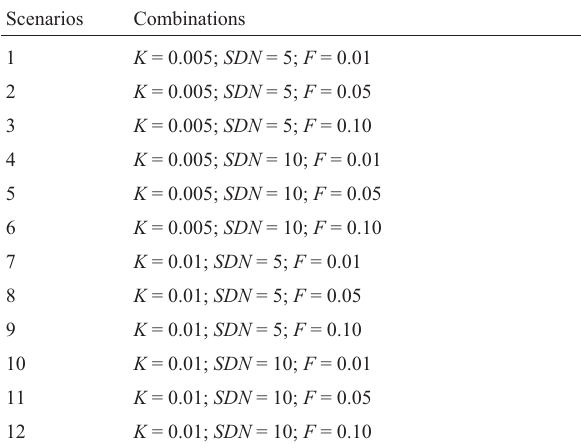
Table 1 - Twelve simulation scenarios based on the combination of three variable parameters: Carrying capacity ( K ), standard deviation of population size ( SDN ) and inbreeding coefficient ( F ).